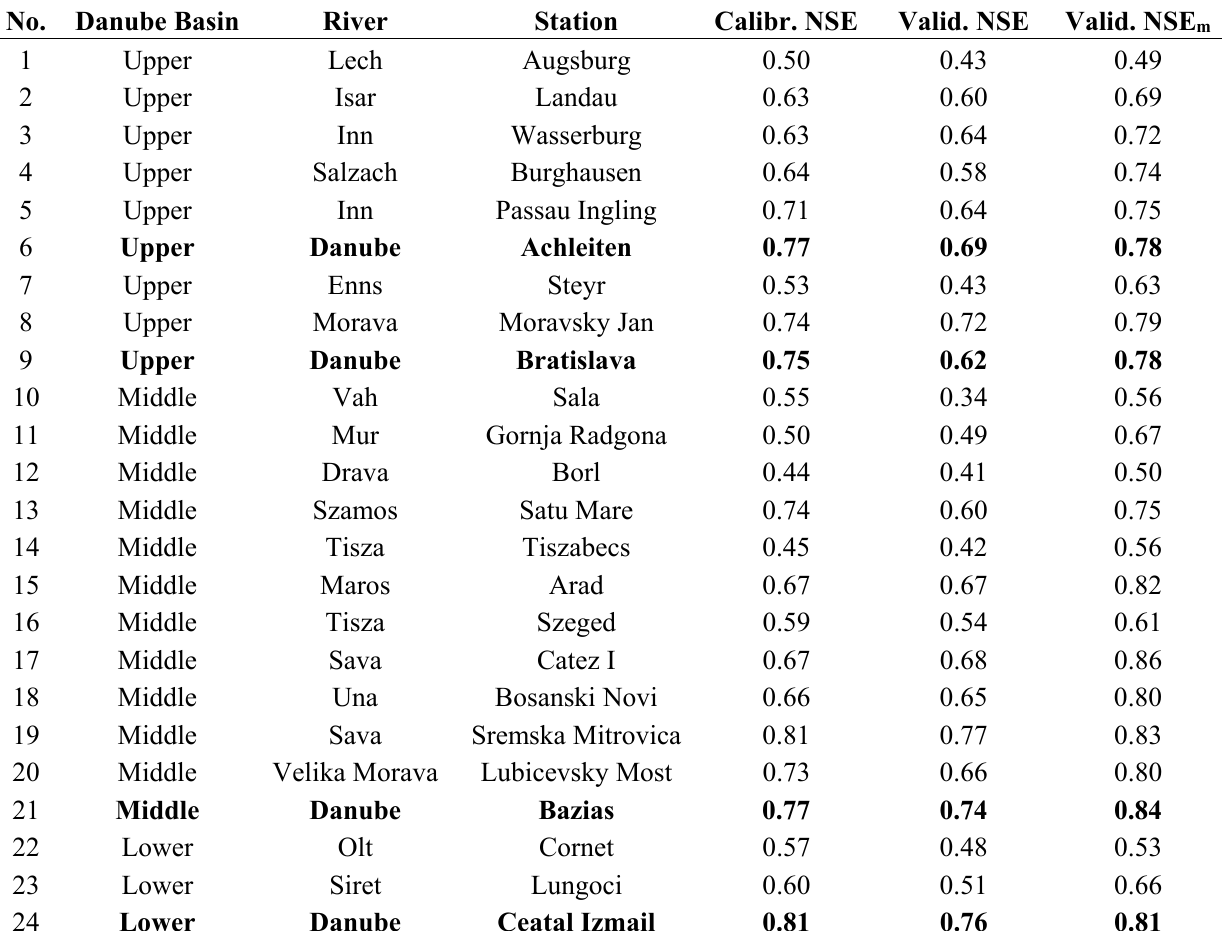
Figure 7. Danube catchment and the 24 selected gauging stations (see Table 2). Table 1. Gauging stations for calibration and validation of the model. NSE, Nash–Sutcliffe model efficiency. Calibr., Calibration. Valid.,